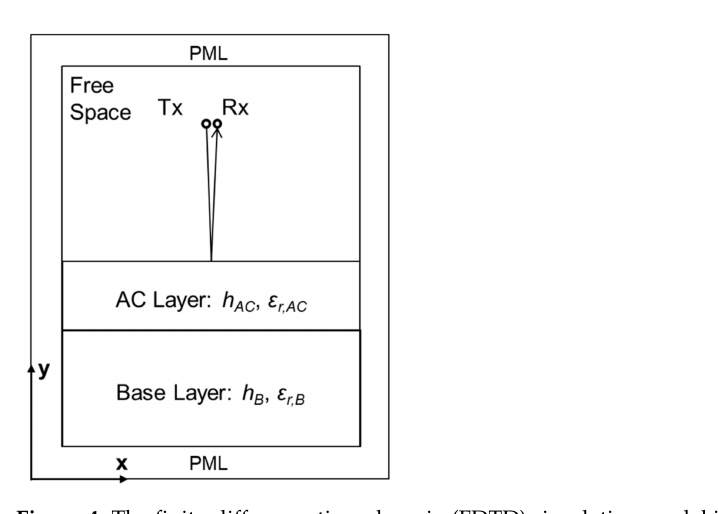
Figure 4. The finite-difference time-domain (FDTD) simulation model in the